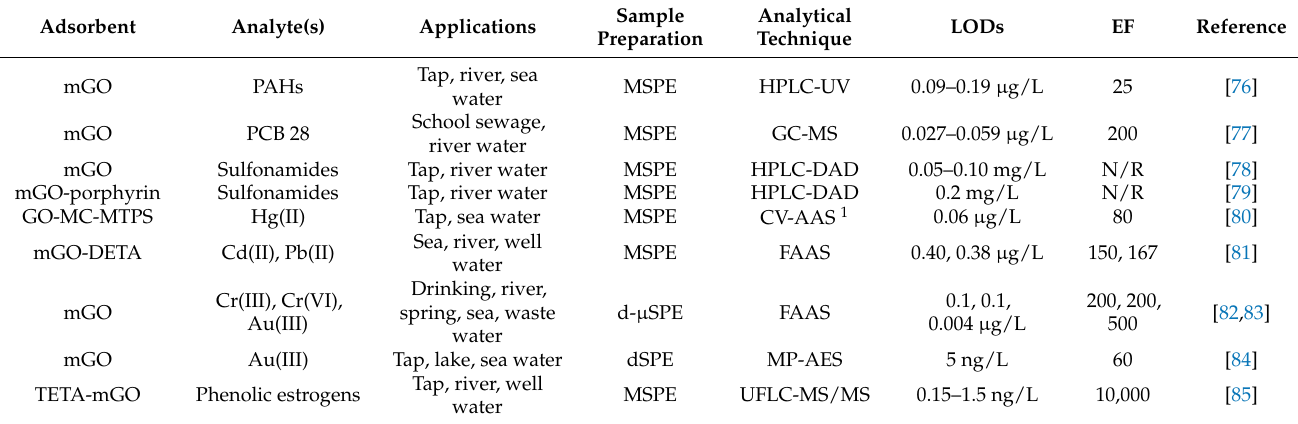
Table 2. Main applications of magnetic graphene-based nanomaterials in environmental samples analysis. Adsorbent